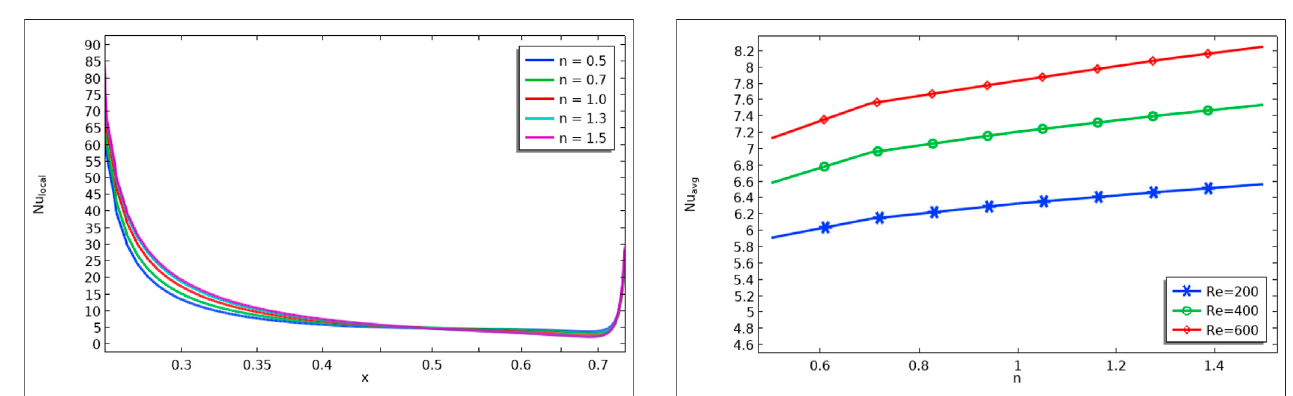
FIGURE 9 | Impact of n on Nu avg for different values of Re